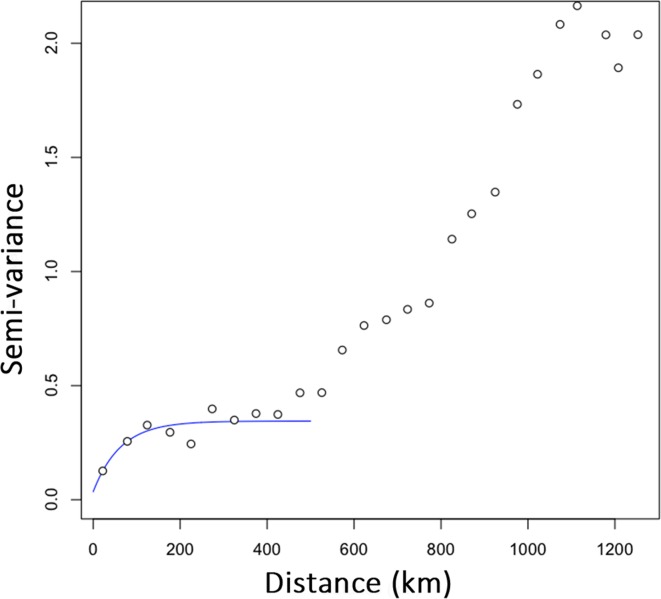
Empirical semi-variogram of genotypes of Monochamus galloprovincialis.The variogram was fitted with an exponential model to highlight the first plateau. Data points are shown with a spatial lag distance of 50 km.